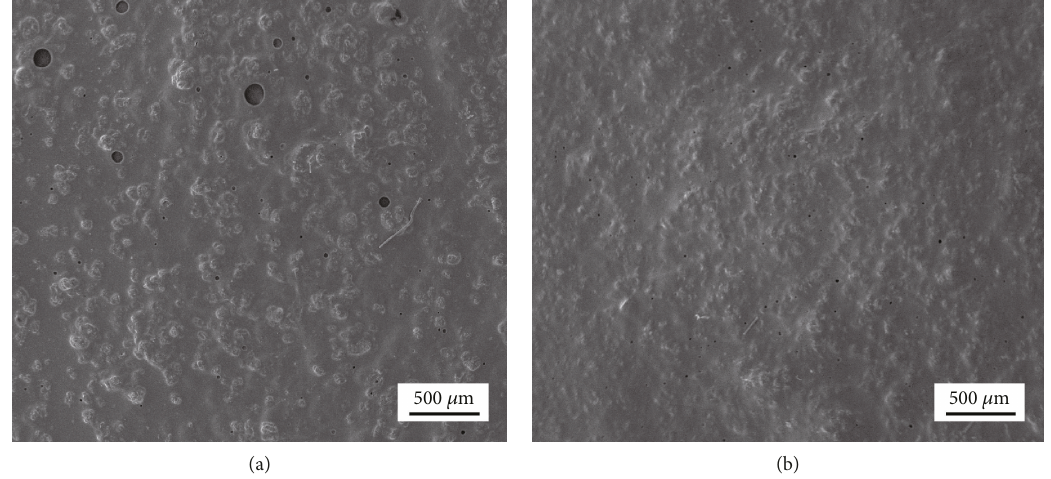
Figure 8: SEM of epoxy resin with 10.0% and 15.0% microcapsule